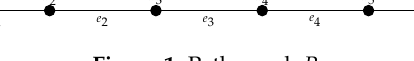
Figure 1. Path graph P 6